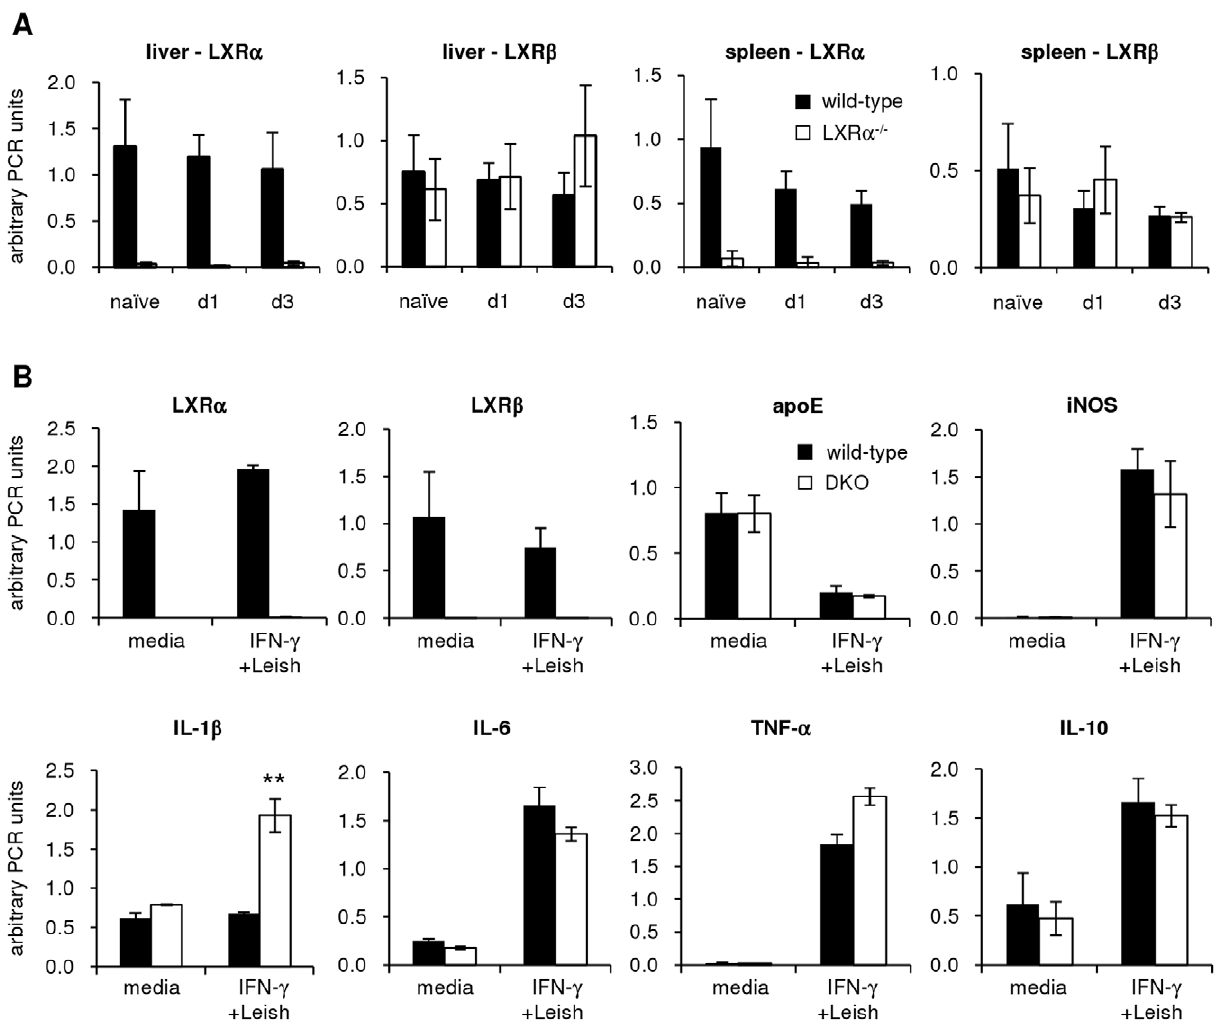
Figure 5. Gene expression in wild-type and LXR-deficient tissues and macrophages following Leishmania infection. A. Wild-type and LXR a -deficient mice were intravenously challenged with 1 6 10 7 live, stationary-phase L. chagasi/infantum parasites, and RNA was prepared from livers and spleens 24 and 72 hours following infection. Real-time RT-PCR was performed with SYBR primers specific for LXR a and LXR b . B. BMDM were preincubated overnight with IFN- c , infected with stationary-phase Leishmania for 1 hour, washed to remove extracellular parasites, and incubated for an additional 2 hours. RNA was harvested, and levels of various genes were determined by real-time RT-PCR. Error bars represent standard deviations of replicate infections; ** denotes p , 0.005. Results are representative of at least 3 independent